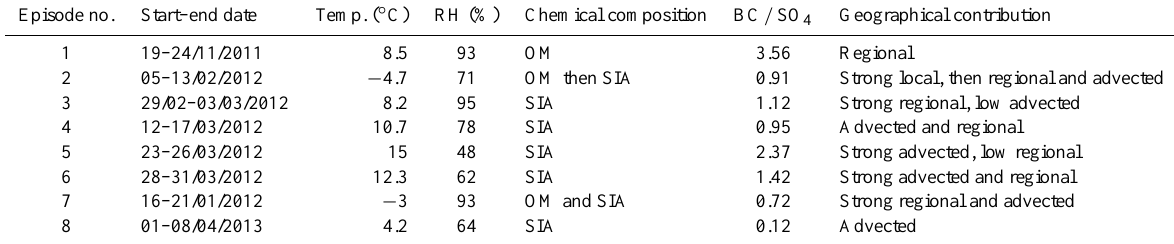
Table 2. Essential parameters describing the eight pollution episodes, such as the start and end dates, average temperature and relative hu- midity, fraction dominating the chemical composition (SIA stands for secondary inorganic aerosols), BC-to-SO 4 ratio and main geographical